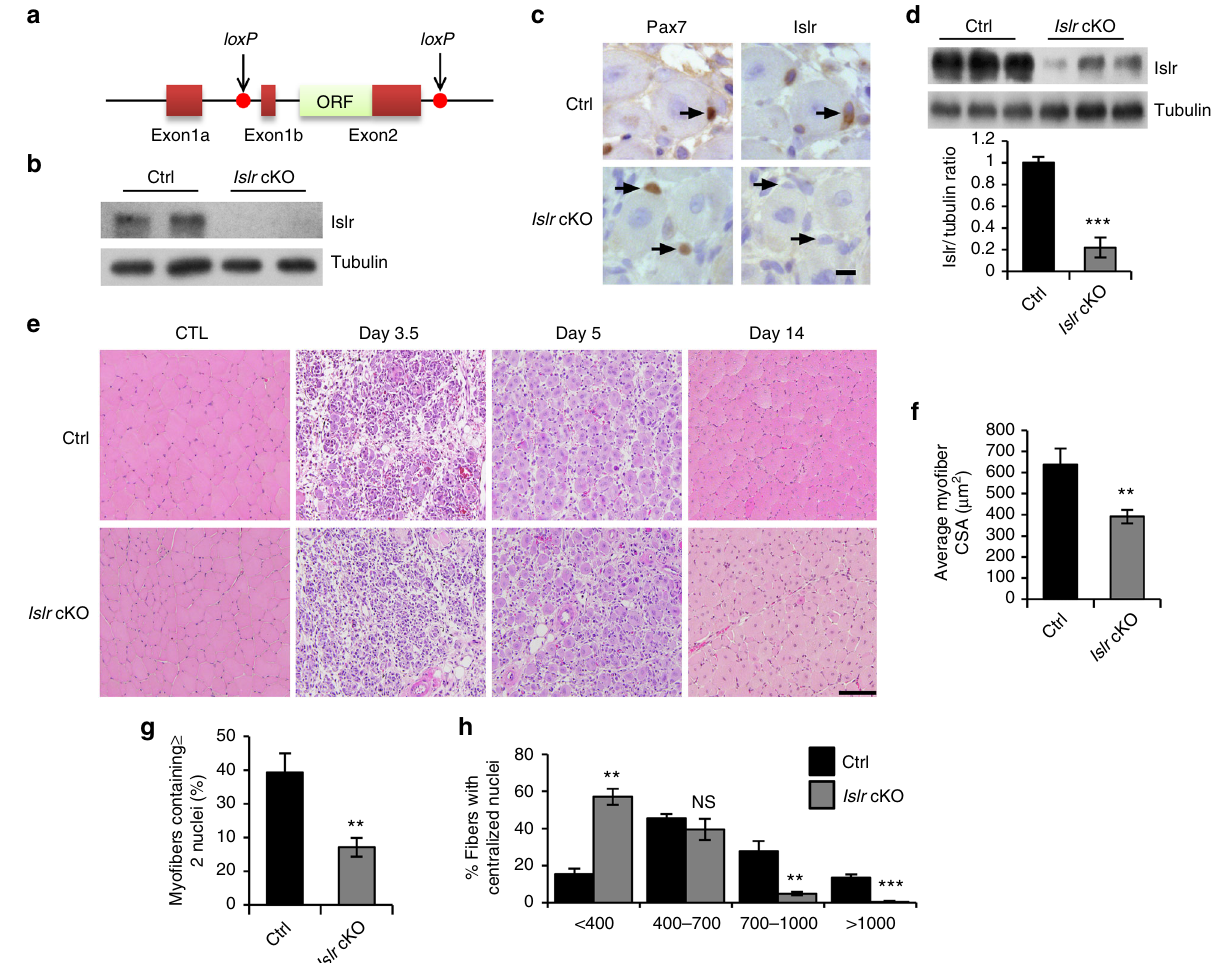
Fig. 2 The deletion of Islr delays skeletal muscle regeneration. a A schematic illustration showing the location of loxP in the Islr gene. b Western blot analysis of Islr protein levels in isolated satellite cells of control and Islr cKO mice cultured for 4 d in proliferation medium. c Immunohistochemistry analysis of Islr in Pax7 + cells of control and Islr cKO mice at 5 d postinjury using serial sections. Scale bar = 10 μ m. d Western blot analysis of Islr protein levels in injured TA muscles of control and Islr cKO mice at 5 d postinjury. e H&E staining of injured and contralateral TA muscles (CTL) in control and Islr cKO mice at 3.5 ( N = 3), 5 ( N = 4), and 14 ( N = 3) d post injury. Scale bar = 100 μ m. f Average cross-sectional area (CSA) of regenerating myo fi bers and g the number of myo fi bers containing two or more centrally located nuclei per fi eld at 5 d postinjury. N = 3 in each group. h Distribution of myo fi ber CSAs at 5 d postinjury. N = 3 in each group. Error bars represent the means ± s.d. NS not signi fi cant, ** P < 0.01, *** P < 0.001; Student ’ s t test. Control (Ctrl): Myf5-Cre + / − , Islr fl / fl ; Islr cKO: Myf5-Cre + / − : Islr fl / fi bers with an area greater than 1000 μ m 2 were almost nonexistent in Islr cKO mice (Fig. 2h). These results demon- muscle.